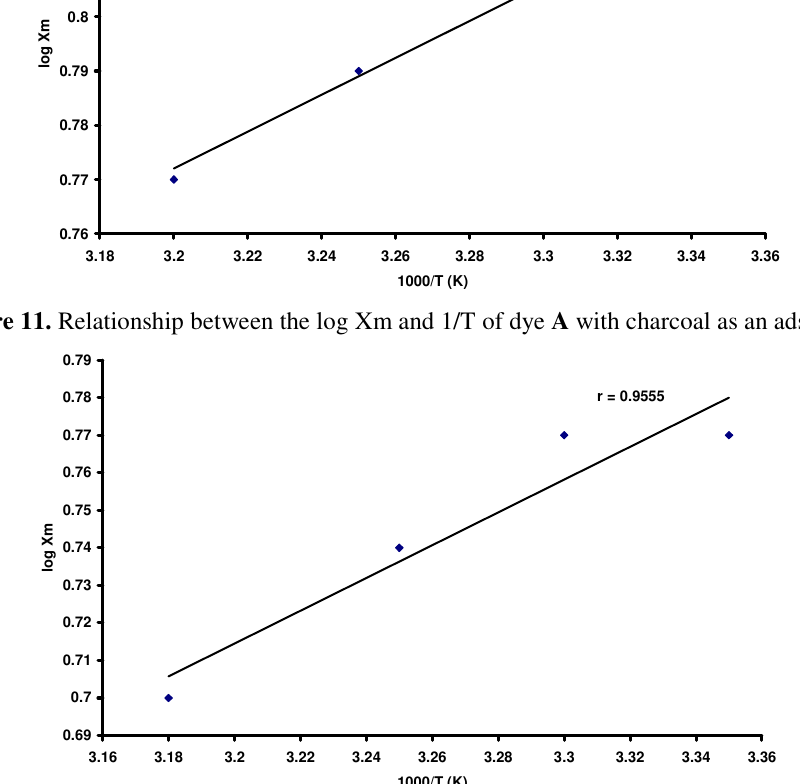
Figure 12. Relationship between the log Xm and 1/T of dye B with charcoal as an adsorbent The apparent adsorption enthalpy is -4.49 kcal /mol for the sulphanilic azo imidazole dye and - 7.41 kcal /mol for sulphanilic azo antipyrine. The low value of adsorption enthalpy indicates a physical adsorption 17